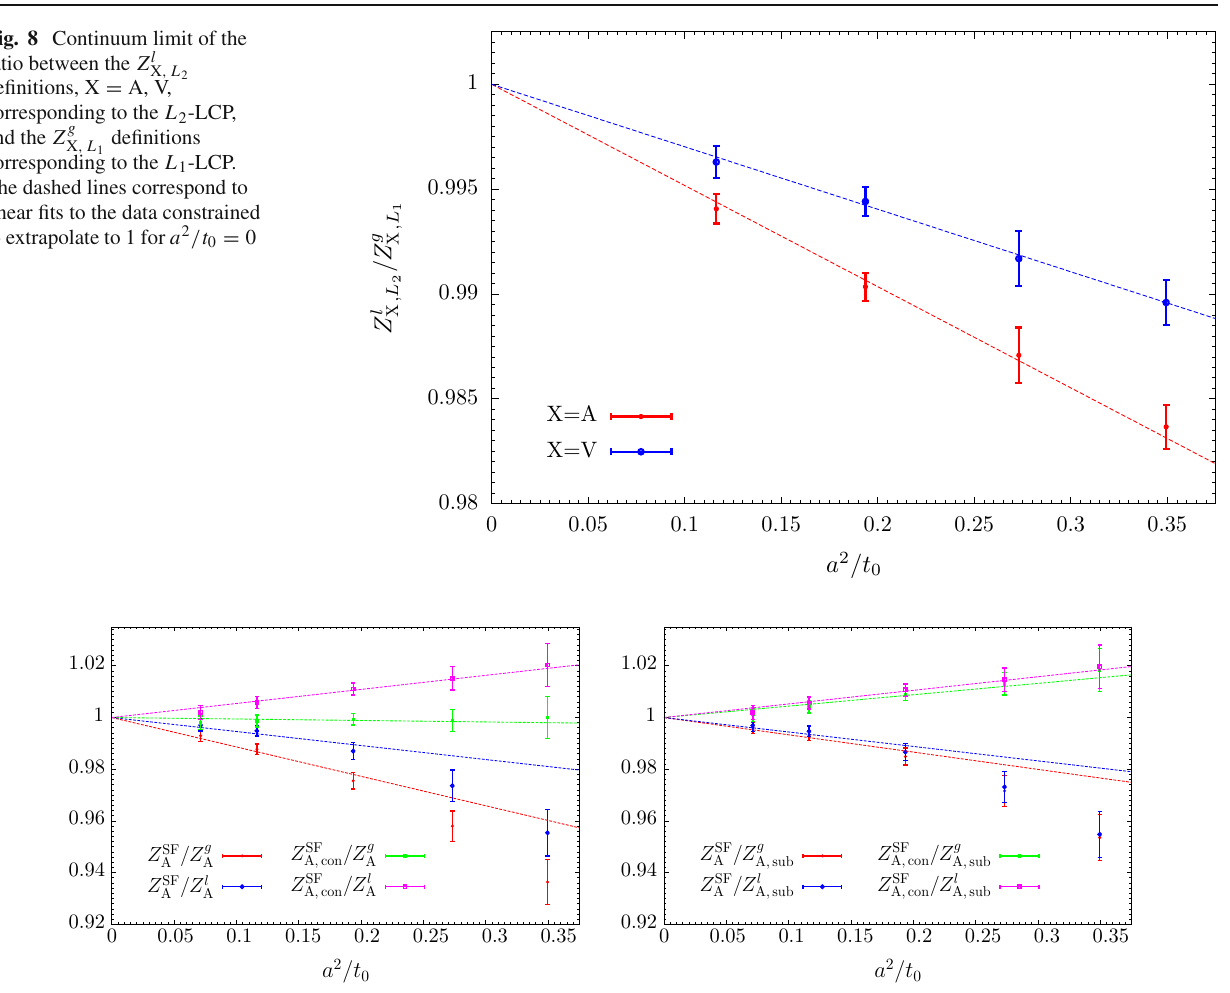
Fig. 9 Continuum limit of the ratios between the N f = 3 WI deter- linear fits to the data with a 2 / t 0 < 0 . 2, constrained to extrapolate to 1 , l for a 2 / t 0 = 0. The Z SF results come instead from a fit of the results minations of Z A of Ref. [22], and the χ SF determinations Z g (left A , con A , l for the alternative, Z con , definition considered in Ref. [22]. The latter panel) and Z g (right panel) of Table 7. The Z SF results are from A , 0 A A , sub fit was obtained using the same fit ansatz used in Ref. [22] for Z A , 0 . the fit formula provided in Ref. [22], and correspond to their preferred, The associated dashed lines (green and magenta lines) are linear fits to Z A , 0 , definition. The associated dashed lines (red and blue lines) are all data, constrained to extrapolate to 1 for a 2 / t 0 =